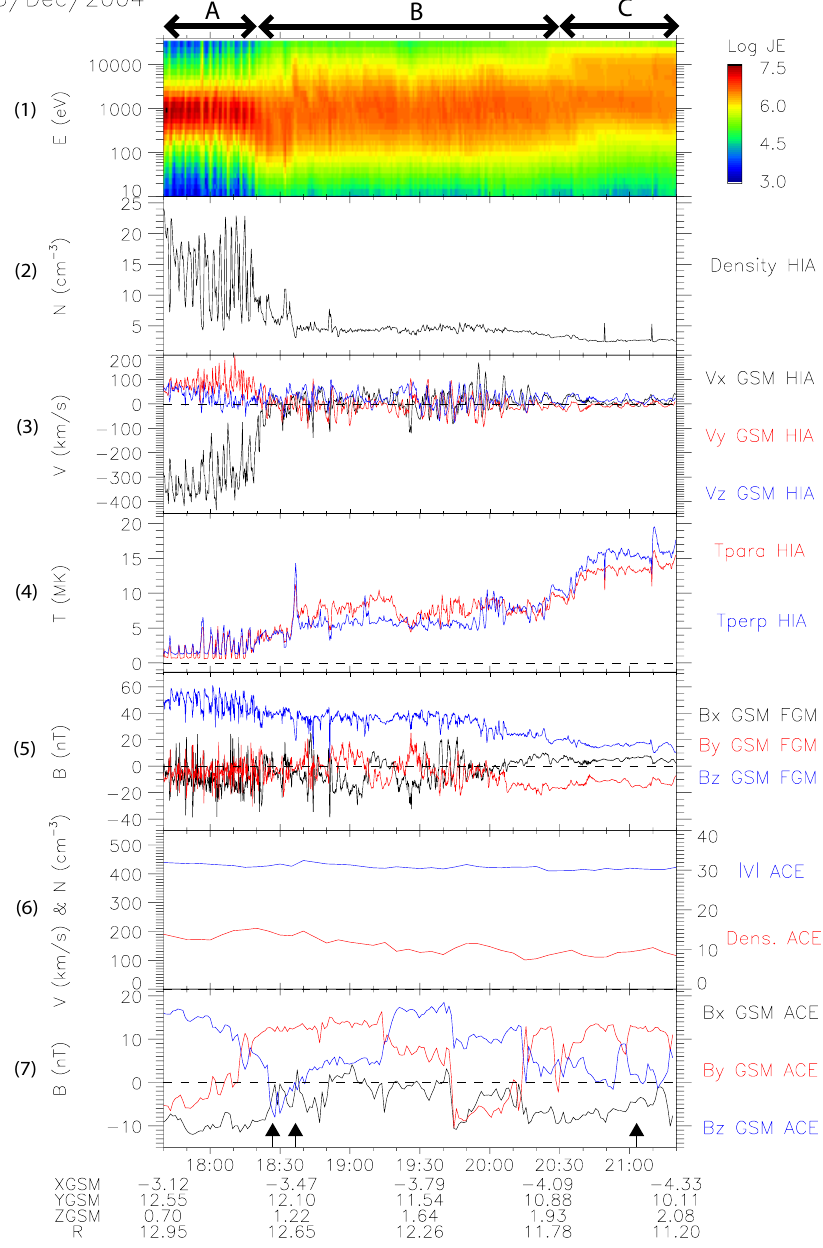
Fig. 1. Double Star 1 and ACE data for the time period 17:40–21:20UT on 5 December 2004. The panels show the HIA ion (1) omni- directional energy-time spectrogram, (2) density, (3) velocity components in GSM coordinates, and (4) parallel and perpendicular tempera- ture. The following panels show (5) FGM magnetic field components in GSM, (6) ACE solar wind velocity magnitude and density, and (7) ACE magnetic field components in GSM. Double Star 1 location is indicated below the time axis. Three arrows show the time at which the ion distributions of Fig. 2 were